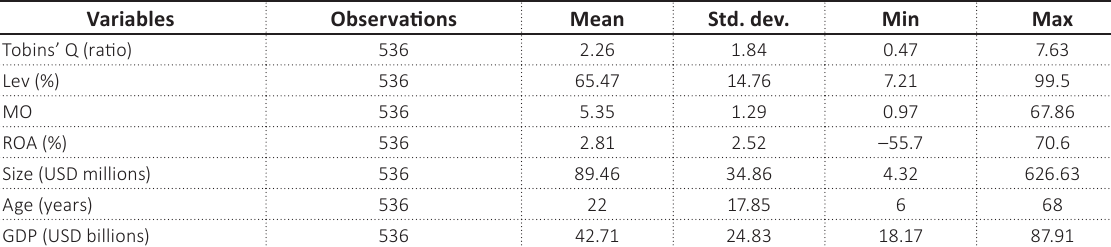
Table 2. Summary statistics and variable